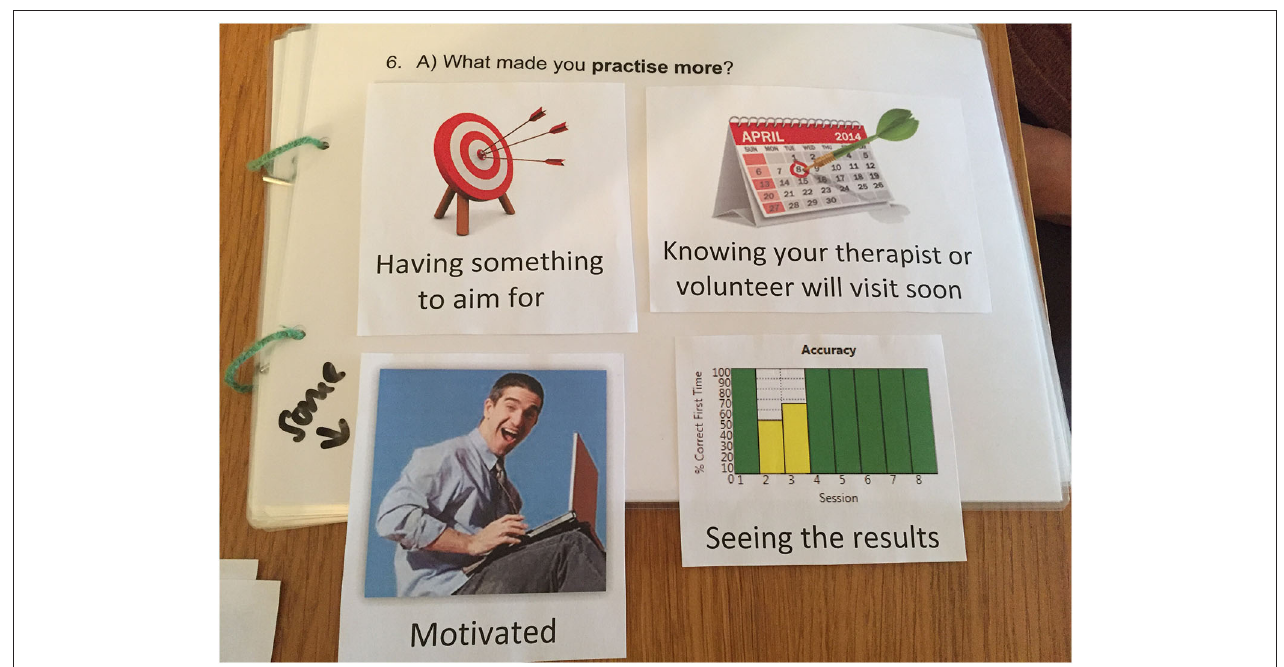
FIGURE 1 | Example of picture selection cards used to facilitate response from participants with more severe communication impairment.